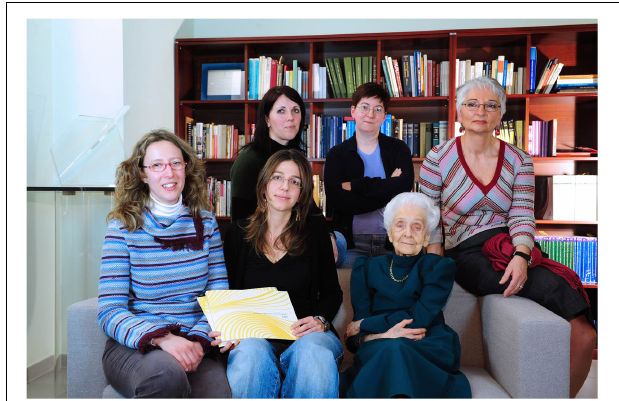
FIGURE 5 | Rita Levi-Montalcini in the office with her group. Behind the sofa, from left to right: Annalisa Manca, Simona Capsoni, and Anna Di Luzio. On the sofa: Francesca Paoletti and Francesca Malerba [Photographer Maurizio Riccardi (Agr Press) from EBRI Media